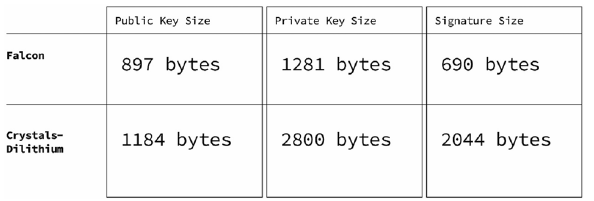
Figure 3. Comparison between Falcon and crystals-dilithium algorithms.